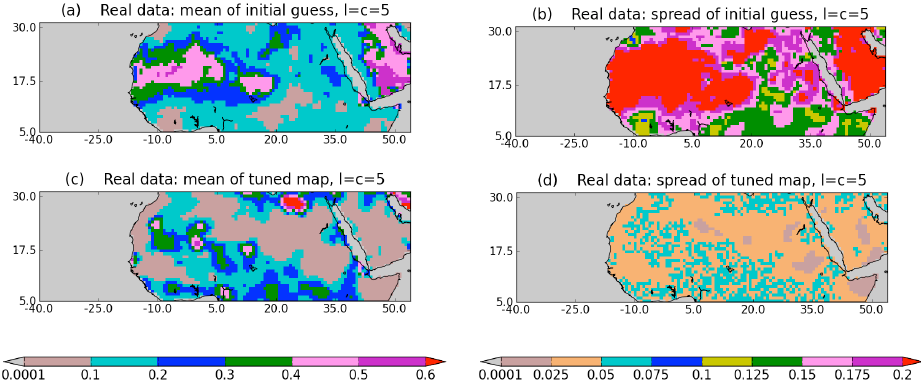
Fig. 8. The tuning experiment with real satellite data. The left colorbar is for (a) and (c) . The right colorbar is for the standard deviations shown in (c) and (d) . (a) The operational values of α are used as mean of initial guess. (b) Standard deviation of initial guess α are is set equal to 0.25. (c) The mean of tuned values after 28 update cycles. (d) The standard deviation of tuned values after 28 updates cycles.